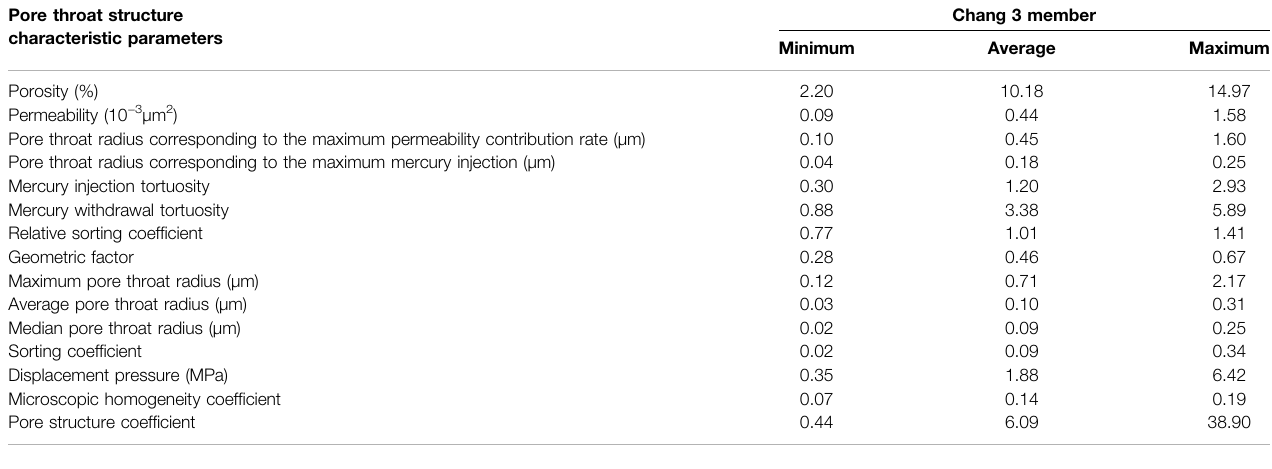
TABLE 3 | Characteristic parameters of pore structures of the Chang 3 reservoirs.